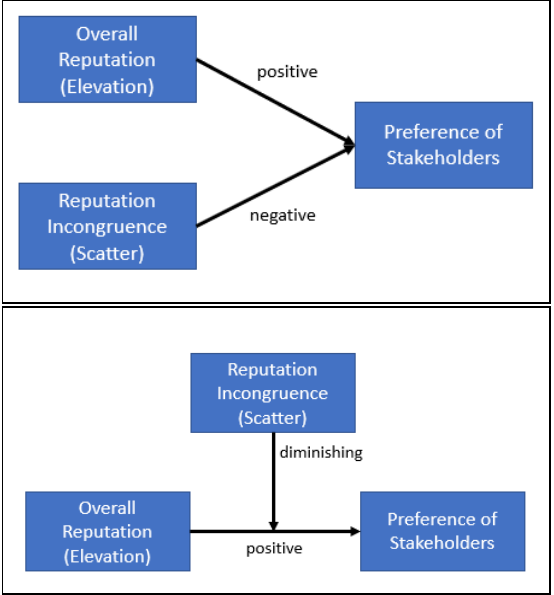
Figure 3. Nomological network of the study’s findings .